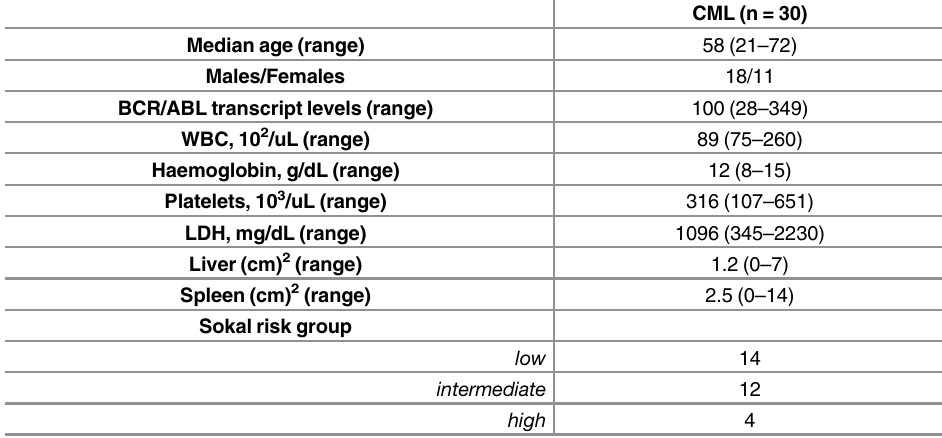
Table 1. Baseline clinical characteristics of patients included in the